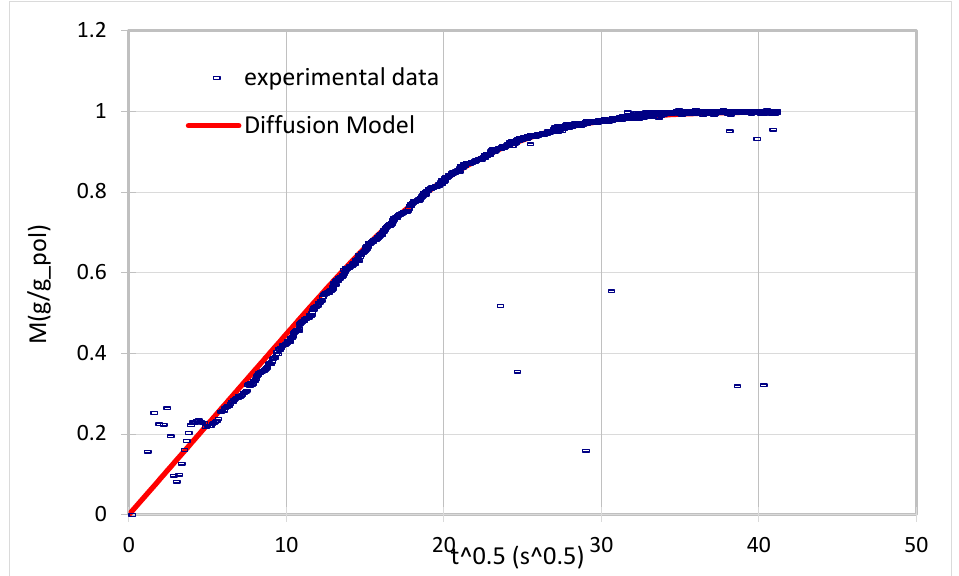
Figure 6. Fitting of the sorption kinetics with the Fickian model (Equation (2)); the data refer to the sorption step between 0.7 and 0.8 activity for the PVAm/cNFC + 45% Arg.